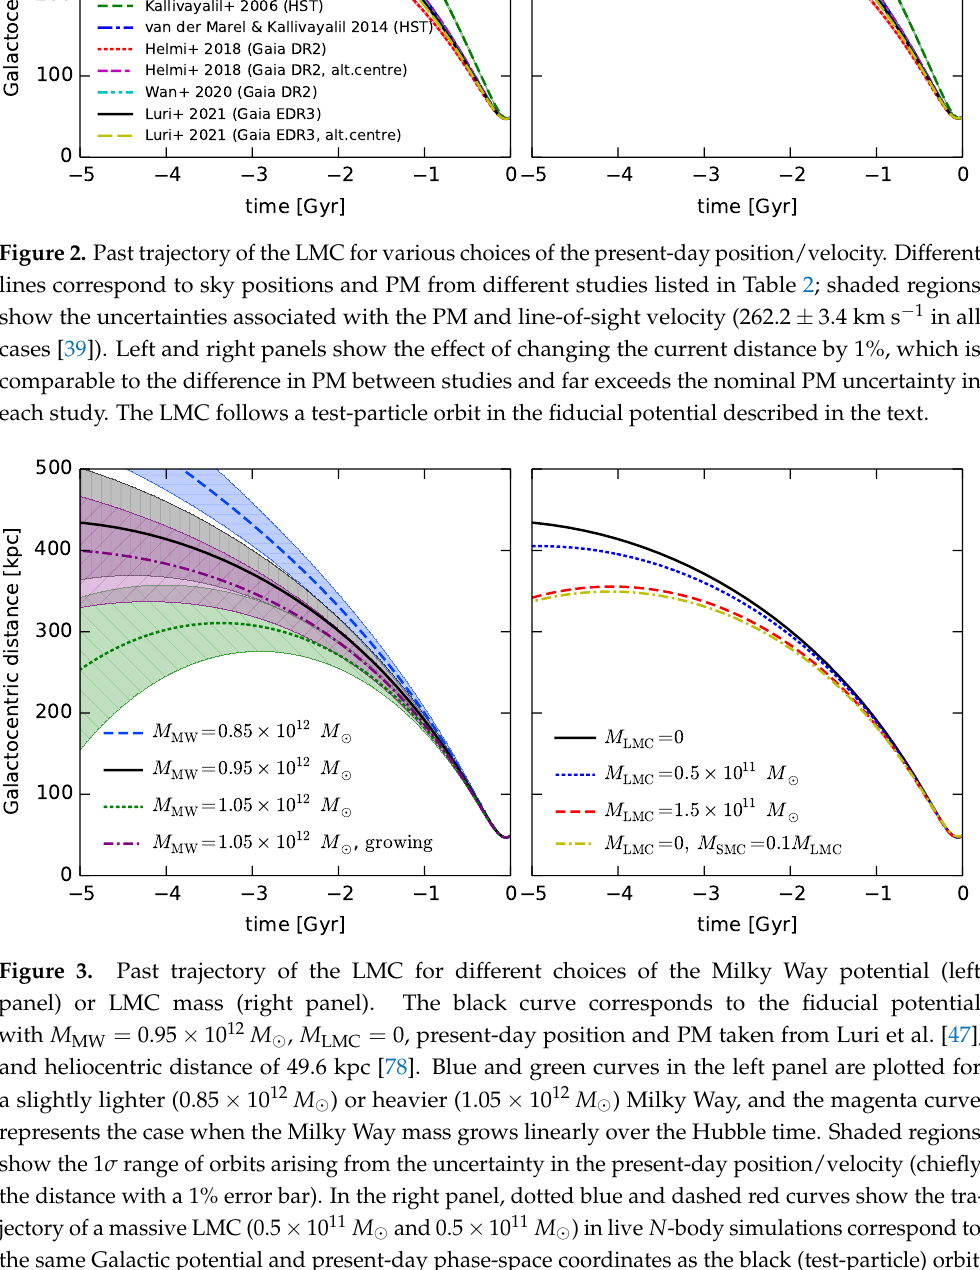
3.4 km s − 1 in all ±